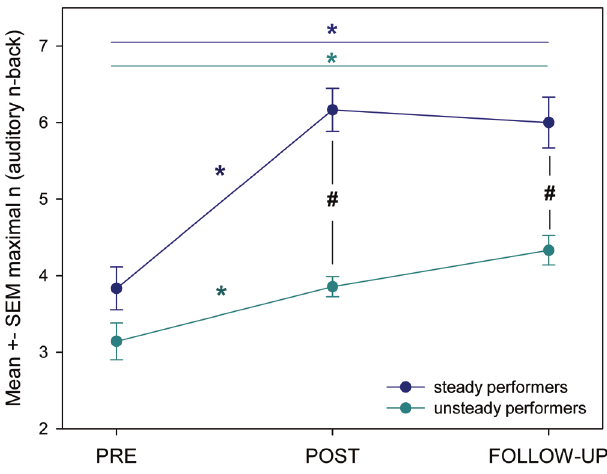
Figure 7. Mean ± SEM in auditory n-back (ANB) for the steady and unsteady training performers. * indicates significant changes within groups [steady performers (blue), unsteady performers (green)]. # indicates p < 0.05 (unpaired t-test between sessions [PRE, POST,